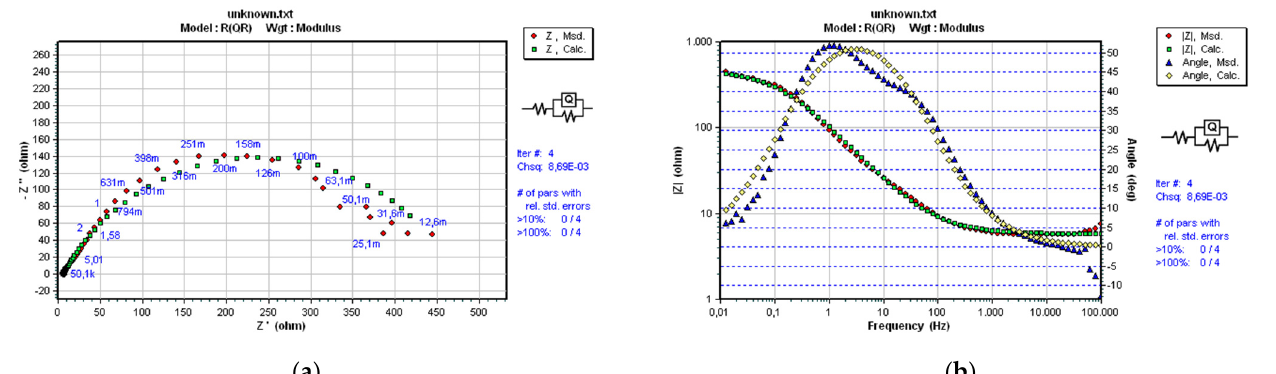
Figure 10. Nyquist ( a ) and Bode ( b ) plots of WC-15Co.